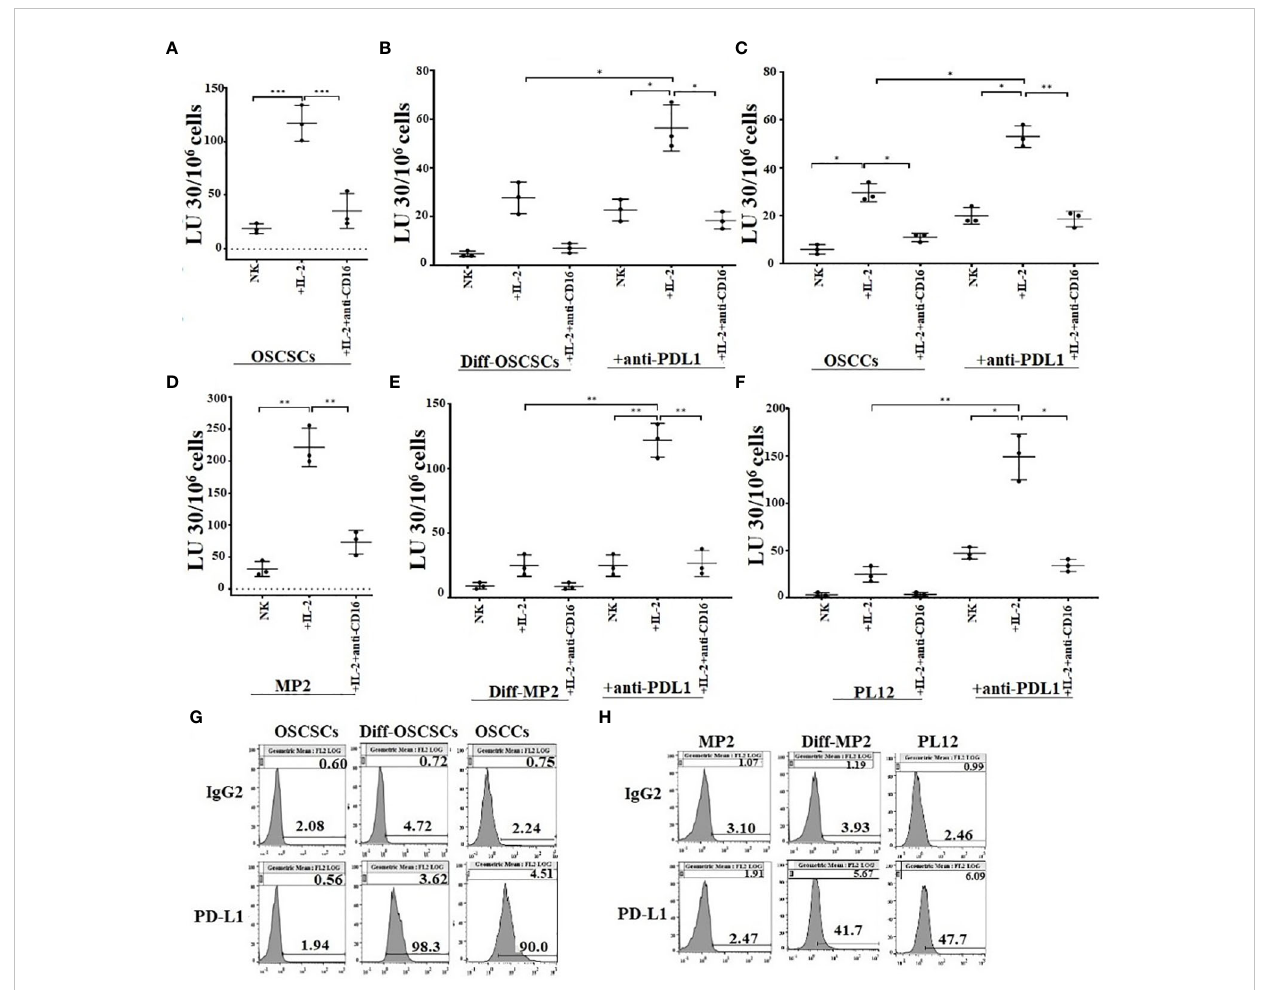
FIGURE 5 Differentiated tumors expressed higher levels of PD-L1 on their surface and were more susceptible to NK cell-mediated cytotoxicity when compared to their stem-like counterparts in the presence of anti-PDL1. Puri fi ed NK cells (1×10 6 cells/ml) from healthy individuals were left untreated, or treated with IL-2 (1000 U/ml), or treated with IL-2 (1000 U/ml) and anti-CD16 mAbs (3µg/mL) for 18 hours and were used as effectors in chromium release assay. OSCSCs were differentiated using IL-2 (1000 U/ml) and anti-CD16 mAbs (3µg/mL) treated NK cell supernatants as described in Materials and Methods section. OSCSCs (A) , NK-differentiated-OSCSCs (B) , and differentiated OSCCs (C) , were labeled with 51Cr for an hour. NK-differentiated- OSCSCs (B) , and differentiated OSCCs (C) , 51Cr-labeled tumor cells were then left untreated or treated with anti-PDL1 (5 µg/ml) for 30 minutes. The unbound antibodies were washed away, and the cytotoxicity against the tumor cells was determined using a standard 4-hour 51Cr release assay. The Lytic units (LU) 30/10 6 cells were determined using the inverse number of NK cells required to lyse 30% of tumors x 100 (n=3) (A – C) . The surface expression of PD-L1 was analyzed on tumor cells using fl ow cytometry. IgG2 isotype control antibodies were used as controls (G) . Puri fi ed NK cells (1×10 6 cells/ml) from healthy individuals were left untreated, or treated with IL-2 (1000 U/ml) or treated with IL-2 (1000 U/ml) and anti- CD16 mAbs (3µg/mL) for 18 hours and they were used as effectors in chromium release assay. MP2 cells were differentiated using IL-2 (1000 U/ml) and anti-CD16 mAbs (3µg/mL) treated NK cell supernatants as described in Materials and Methods section. MP2 (D) , NK-differentiated MP2 (E) , and differentiated PL12 (F) were labeled with 51Cr for an hour. NK-differentiated MP2 (E) , and differentiated PL12 (F) 51Cr-labeled tumor cells were then left untreated or treated with anti-PDL1 (5 µg/ml) for 30 minutes. The unbound antibodies were washed away, and the cytotoxicity against the tumor cells was determined using a standard 4-hour 51Cr release assay. The Lytic units (LU) 30/10 6 cells were determined using the inverse number of NK cells required to lyse 30% of tumors x 100 (n=3) (D, E, F) . The surface expression of PD-L1 was analyzed on tumor cells using fl ow